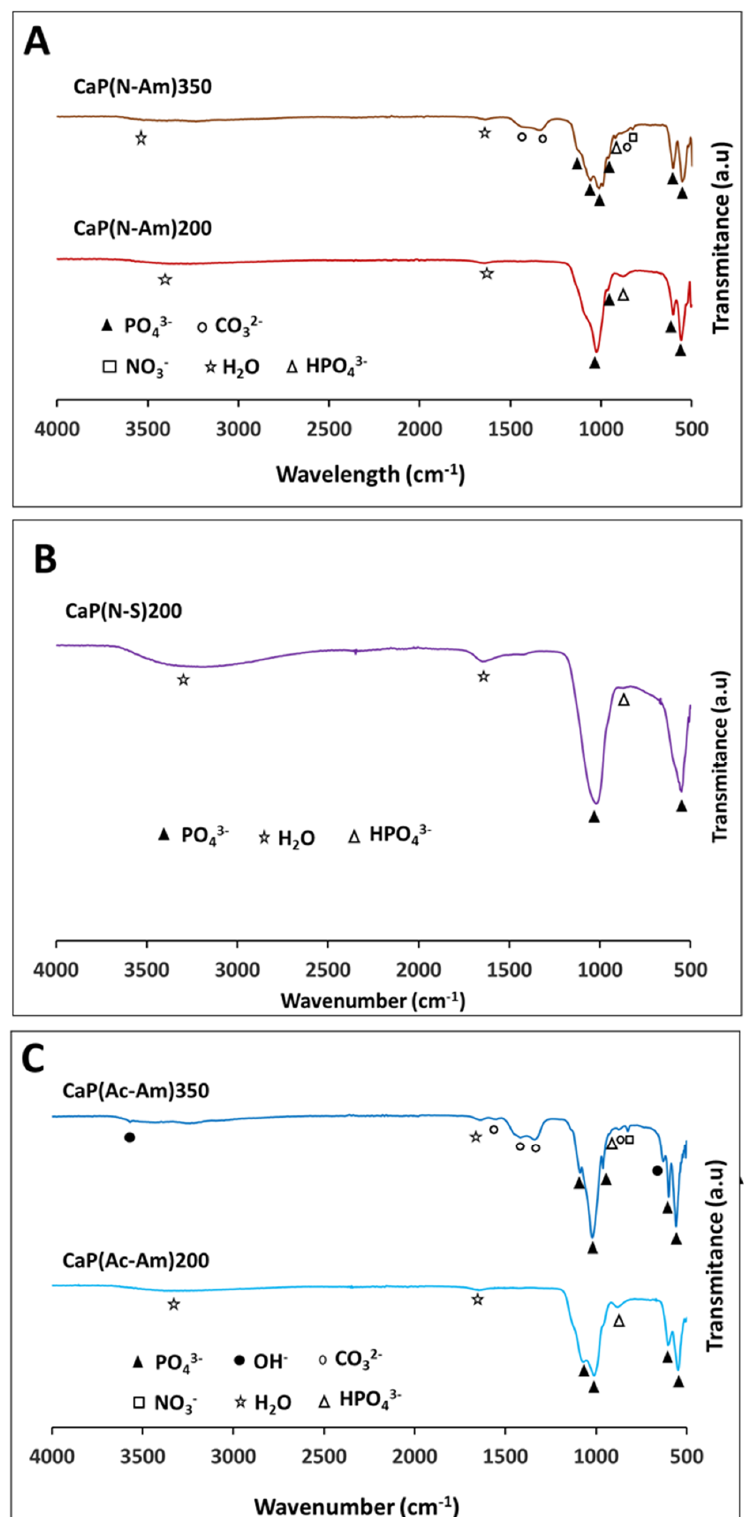
Figure 3. FTIR spectra of samples synthesised at 200 °C and 350 °C at constant pH of 11 and 6 for a calcium nitrate tetrahydrate solution and struvite solution, respectively, where acid and base solutions were as follows: ( A ) HNO 3 and NH 4 OH, ( B ) HNO 3 and NaOH, and ( C ) CH 3 COOH and NH 4 OH, respectively.